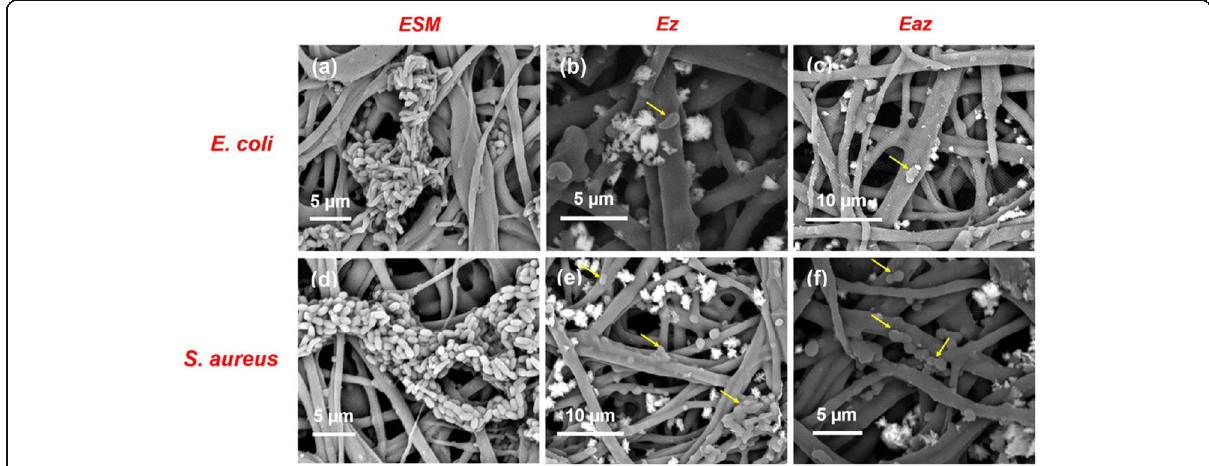
Fig. 11 FESEM analysis of the bactericidal activity of nanobiocomposites and bare ESM. a , d Morphology of E. coli and S. aureus on bare ESM. b , e Efficiency of Ez towards E. coli and S. aureus ; (c and f) efficiency of Eaz composites on the bacteria. Reproduced from ref. [23] with permission from the American Chemical